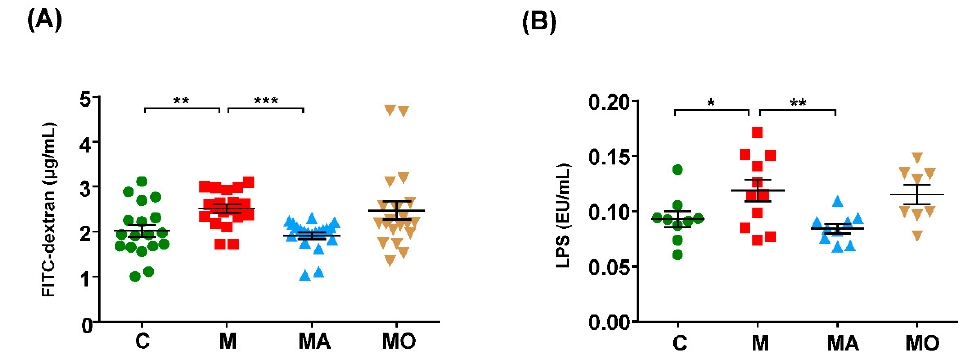
Figure 4. OCA supplementation restored the gut microbiota-mediated increased intestinal permeability and endotoxemia in HFHS diet mice. HFHS diet mice displayed leaky gut and endotoxemia and were reversed by ABX supplementation. OCA treatment restored the intestinal permeability and serum LPS concentration to a normal level. ( A ) The intestinal barrier was evaluated according to the serum concentration of FITC-dextran. ( B ) The serum LPS levels were measured. Note: data are given as mean ± SEM. n : ( A – B ) 8–12 per group. * p < 0.05; ** p < 0.01; *** p < 0.001. Groups: C, mice with normal chow; M, mice with HFHS diet; MA, ABX-treated HFHS diet mice; MO, OCA-treated HFHS diet mice. Abbreviations: HFHS,